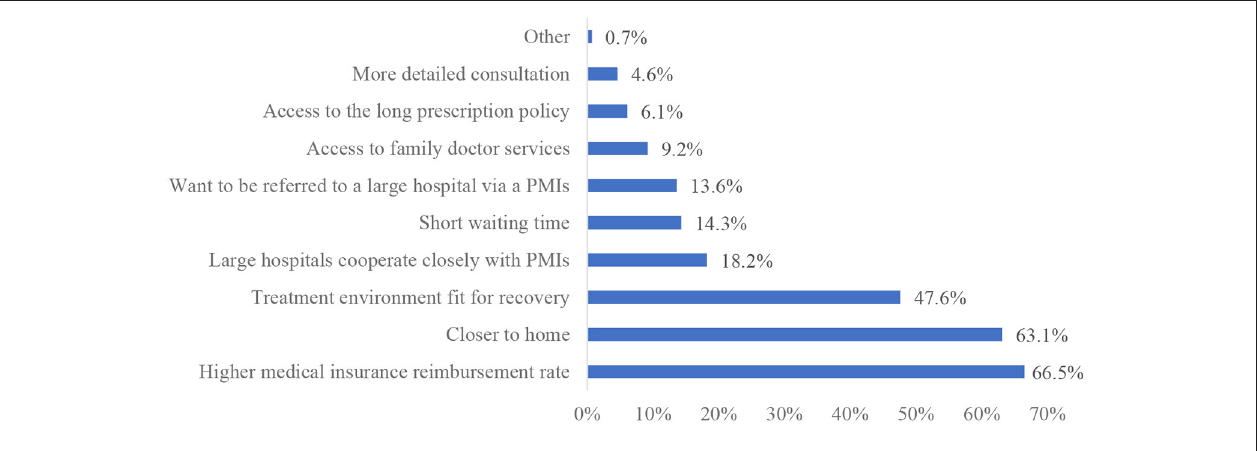
FIGURE 2 | Reasons for patients’ willingness for first visit in